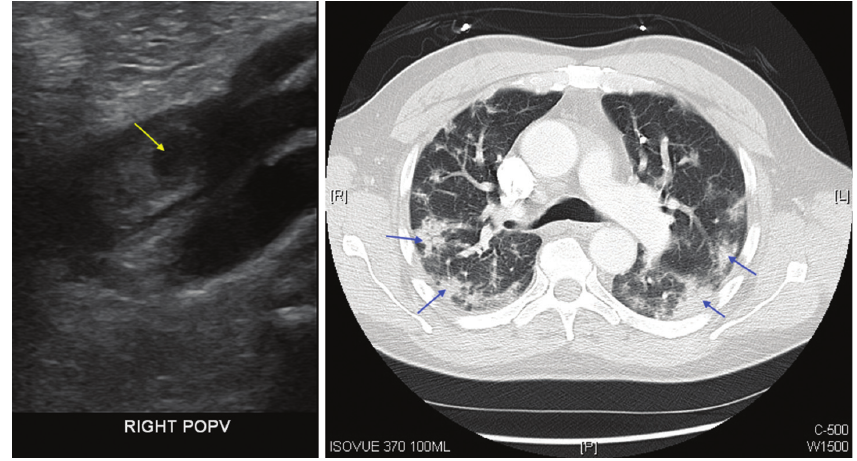
Fig. 2 Left panel shows DVTon ultrasonography (yellow arrow); right panel shows CTwith ground glass opacities (blue arrows). CT, computed tomography; DVT, deep vein thrombosis.